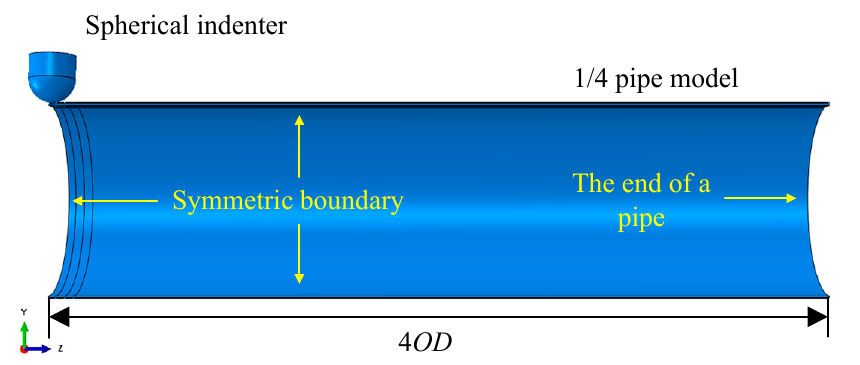
Figure 7. Geometric model of 1/4 pipe with external corrosion.